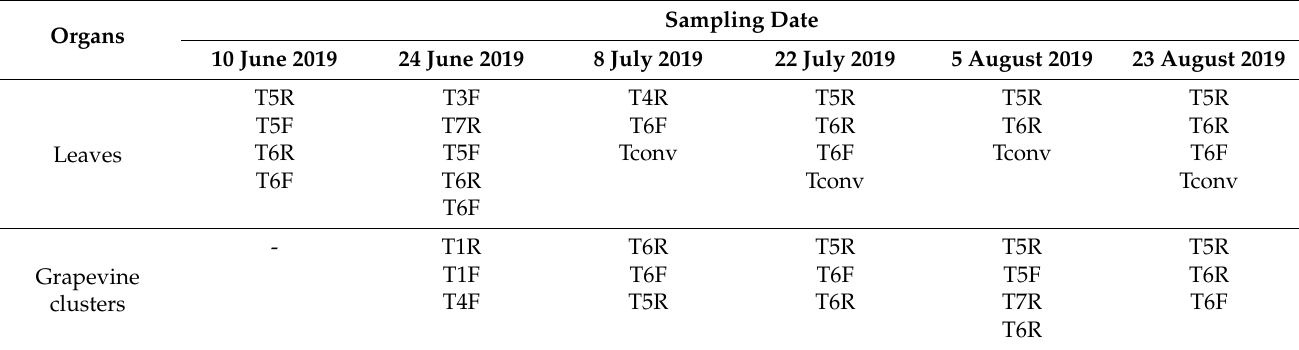
Table 2. Summary of the most effective treatments (lowest degree of attack) on leaves and grapevine clusters for each sampling date. Results are based on non-parametric analysis using the Kruskal–Wallis